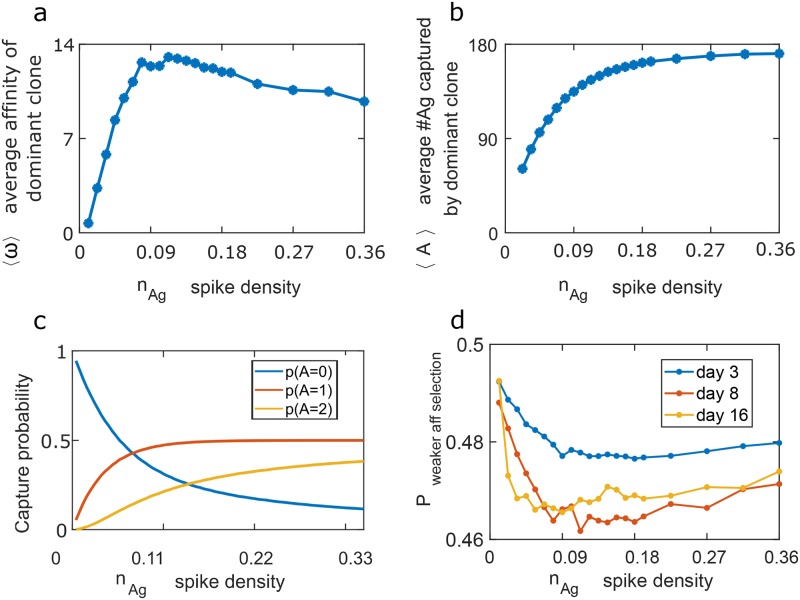
Affinity maturation (AM) in a germinal center (GC).Simulations of the GC reaction starting with 20 different B cell clones. During AM, cells mutate their BCR upon division, changing only the BCR interaction energy with the Ag (EAg−Ab) and thus the off-rate r0 of the BCR from the Ag. (a) The mean affinity (ω = q/r0) of the dominant clone at day 16 of the GC reaction in the competitive phase, as a function of spike density nAg. (b) Mean number of Ag molecules captured by the dominant clone at day 16 as a function of the spike density. (c) The capture probability of Ag molecules by a single BCR (Eq (S10)) when the binding energy of the BCR is EAg−Ab = 1.5. The other parameters of the captures process are listed in Table 2. (d) The probability of selecting the weaker affinity B cell (see text) during the competitive phase. This probability depends on the spike density (Eq (S11)). We sampled energies of B cell pairs from the population energy distribution (S5 Fig) obtained in the simulation results shown in (a), to estimate the probability of the lower affinity cell proliferating before a higher affinity one, at different times during the GCR. The relative mild variation in this figure are amplified in multiple rounds of selection.